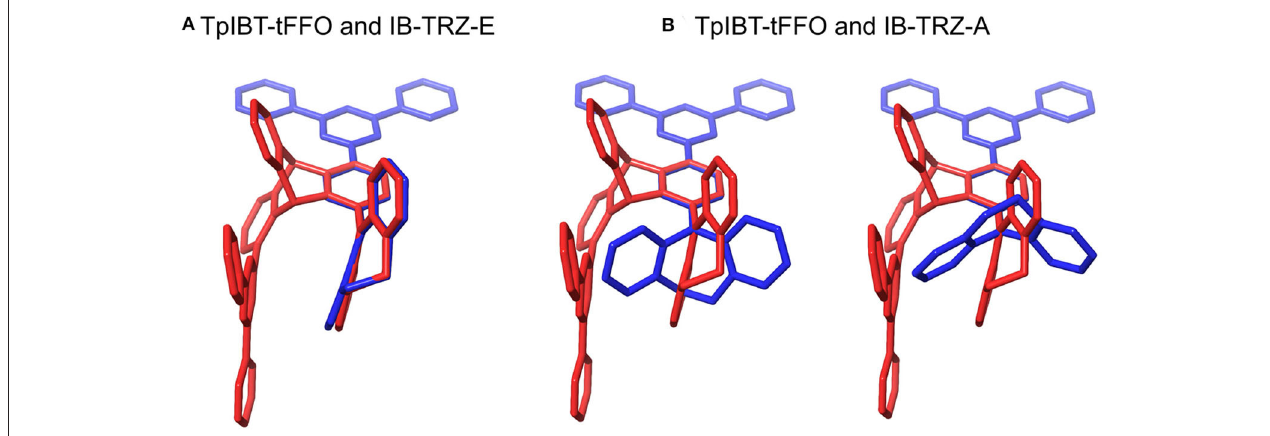
FIGURE 2 | Overlap views of (A) TpIBT-tFFO (red) and IB-TRZ-E (blue) as well as (B) TpIBT-tFFO (red) and IB-TRZ-A (blue). All structures are DFT-optimized.